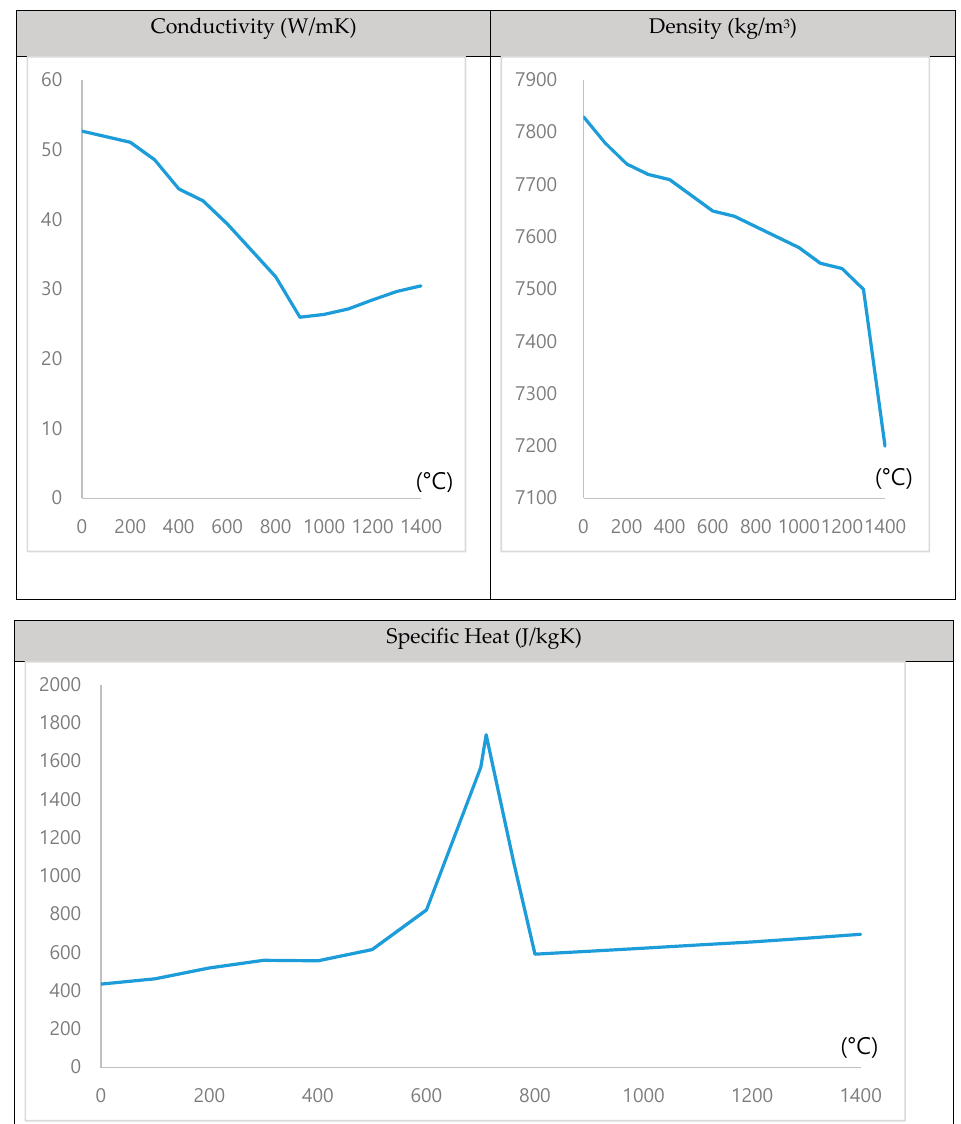
Figure 7. Modeling for FEM analysis applying a moving heat source.